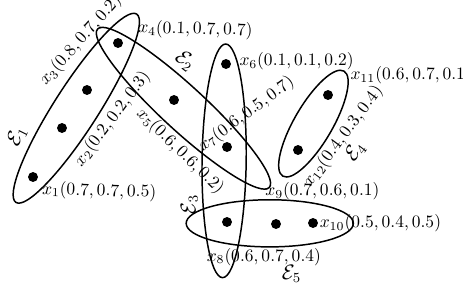
Figure 7. A seven-rung picture fuzzy hypergraph (RPFH).